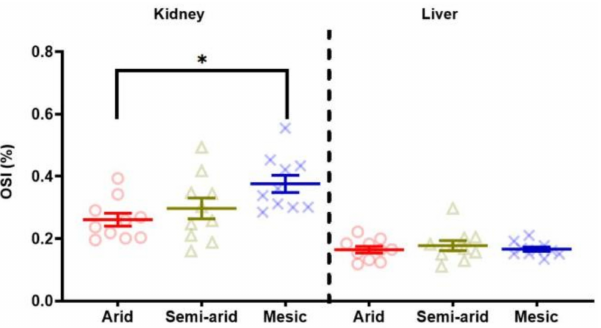
Figure 4. Kidney and liver oxidative stress index (OSI—%) of the common mole-rat ( Cryptomys hottentotus hottentotus ) for each population along an aridity gradient (arid—red (circles), semi-arid— moss (triangle), mesic—blue (x)). The OSI is the ratio of total oxidant status (TOS) to non-enzymatic total antioxidant activity (TAC). Mean ± s.e.m. An asterisk (*) indicates significance ( p ≤ 0.05).